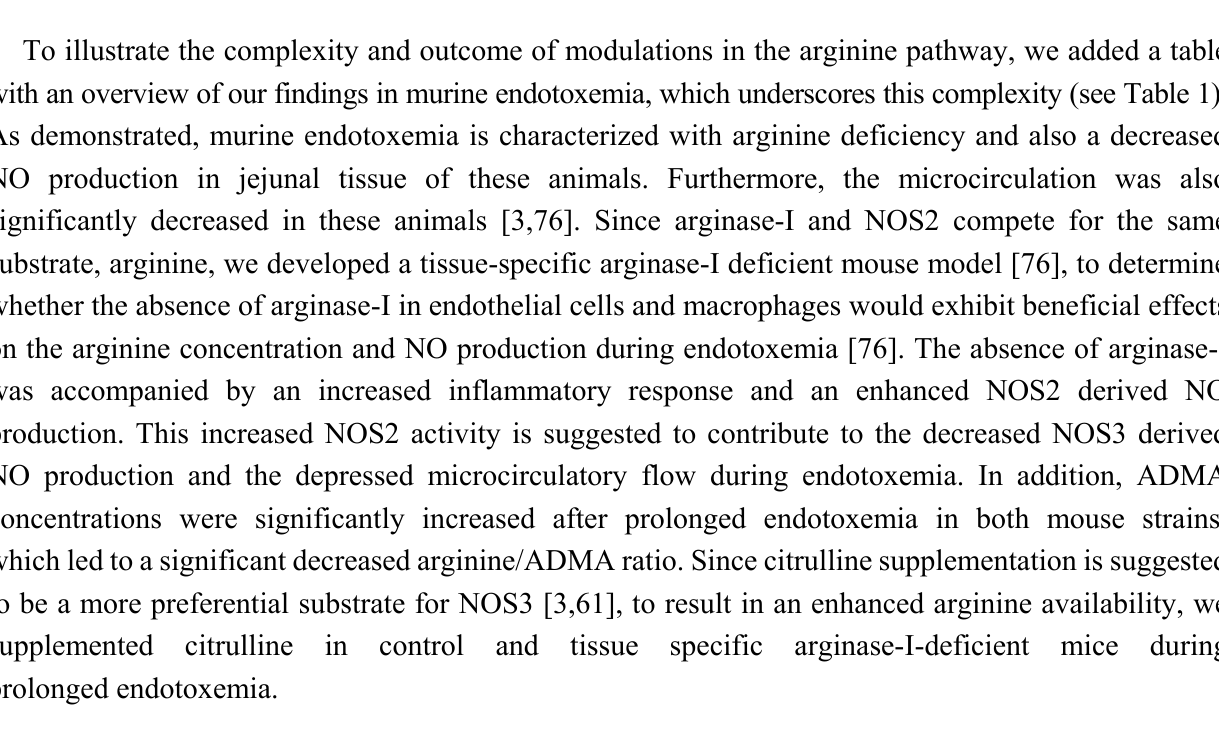
Table 1. Summary of modulations in the arginine-NO metabolism during endotoxemia to illustrate the